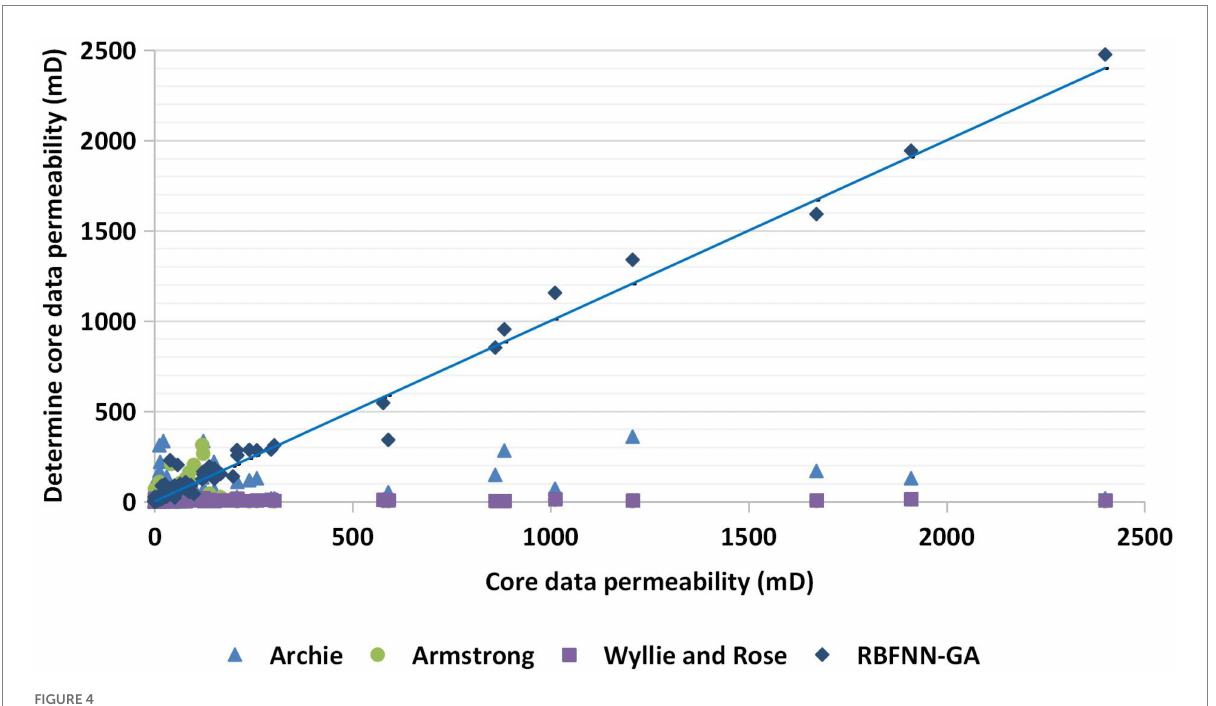
FIGURE 4 Cross-plot for k prediction based on RBFNN-GA algorithm and empirical equations.